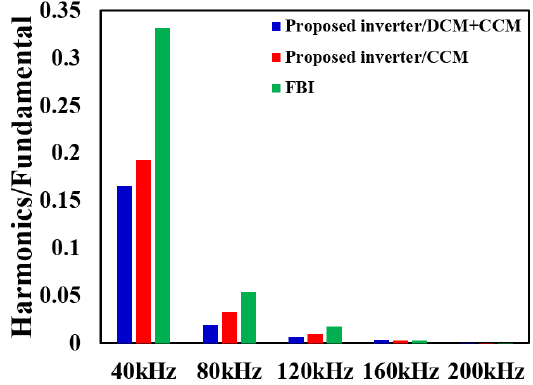
Figure 16. Harmonic components of i o ; measured at V in = 400 V DC , V grid = 220 VAC/60 Hz, f s = 20 kHz, P o = 150 W, Q o = 0 VAR, and I o = 0.95 A.